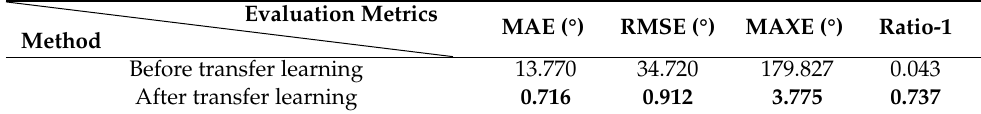
Table 3. Test results before and after transfer